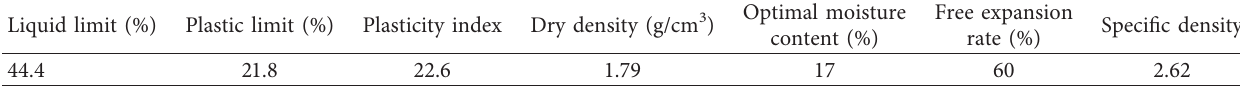
Table 1: The physical and mechanical properties of expansive soil samples.